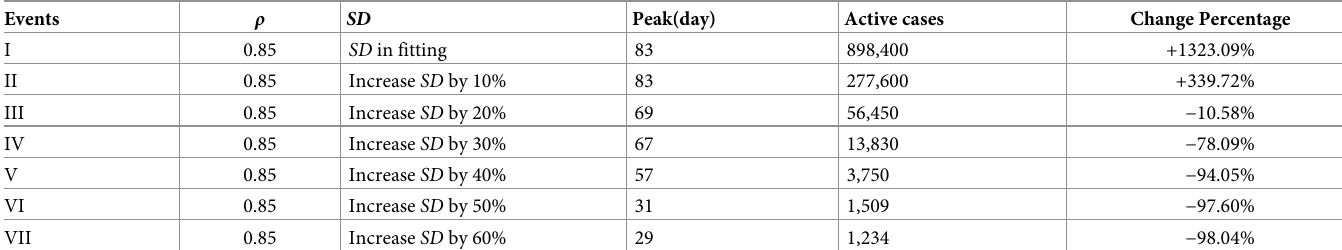
Table 12. Results of different scenarios Second Case, 2 nd scenario.